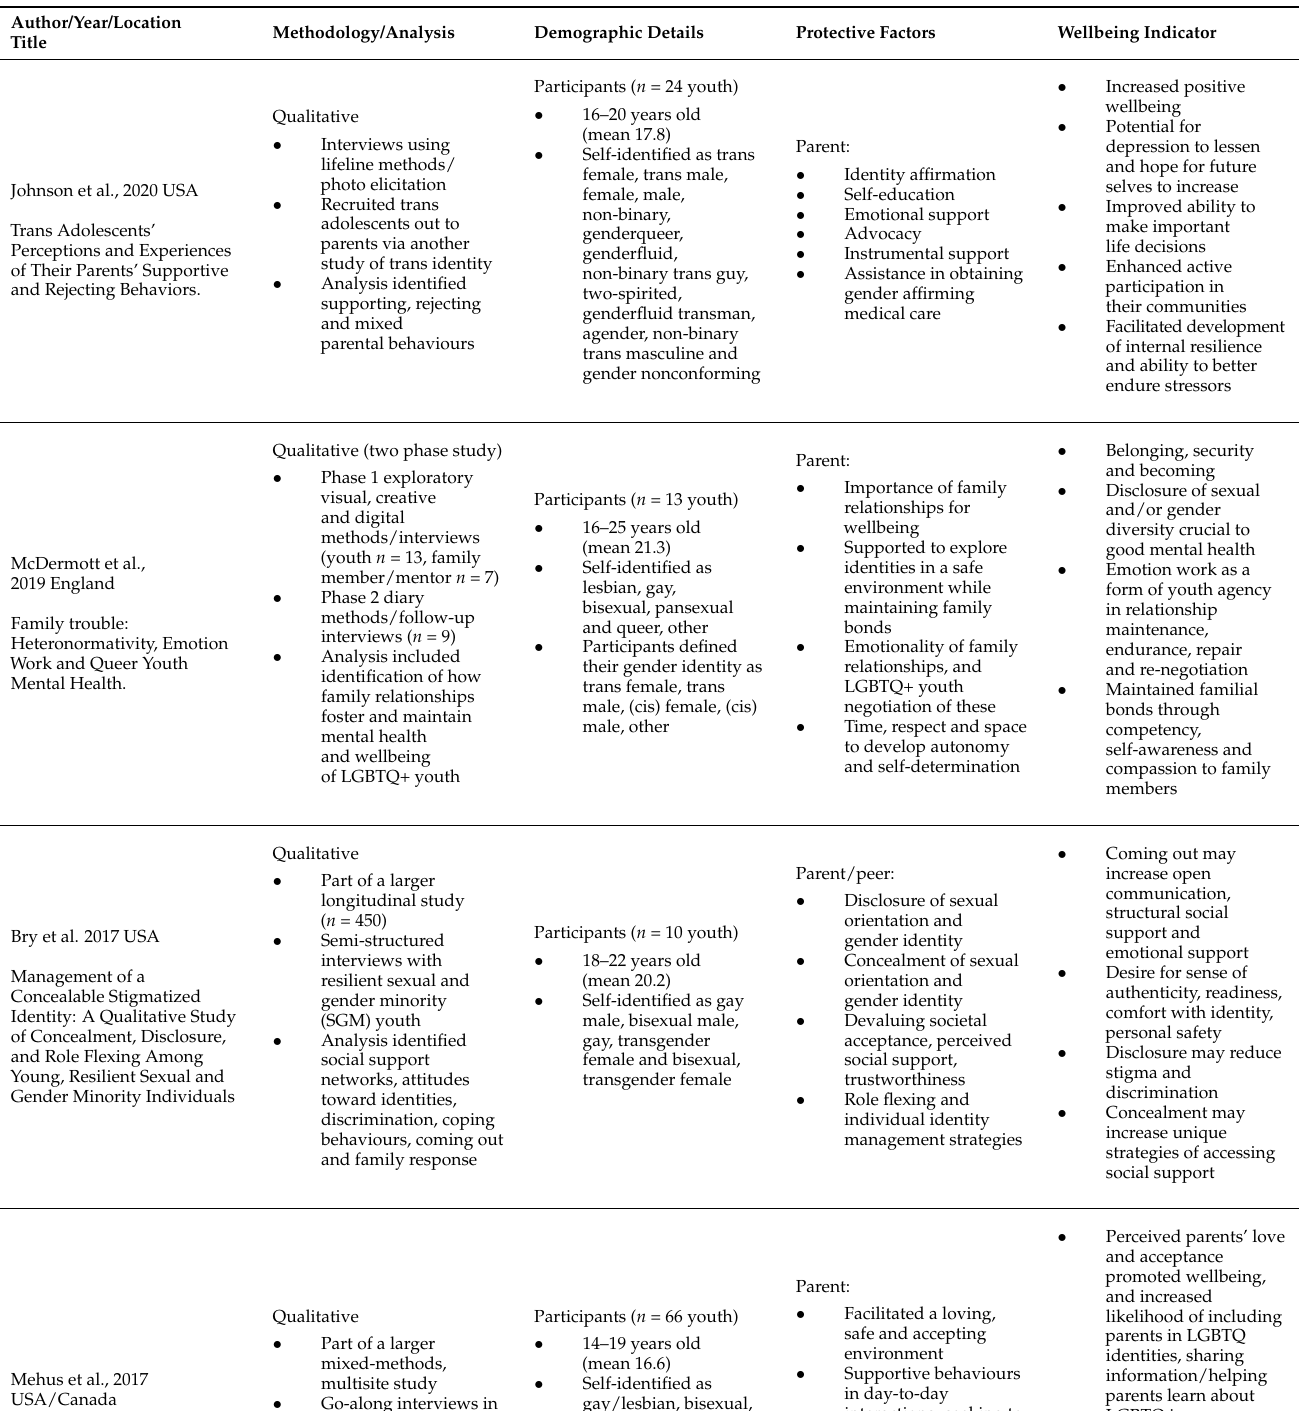
Table 3. Qualitative, mixed-methods research and systematic review records of interpersonal relations: parental, peer and provider protective factors for LGBTI+ youth wellbeing: ( n =